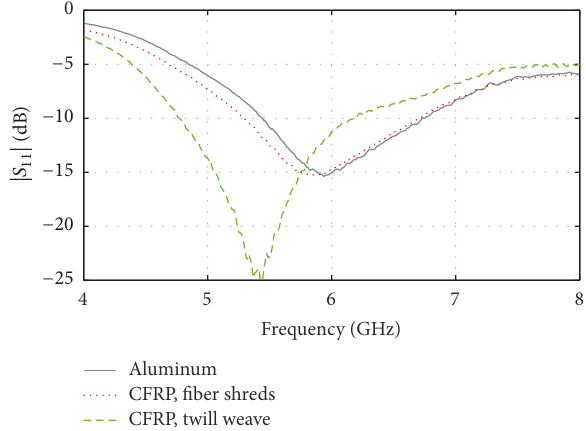
Figure 9: Measured S -parameters of the wire monopole antennas on different ground planes (reprinted with permission from [34]; ©2014 IEEE).